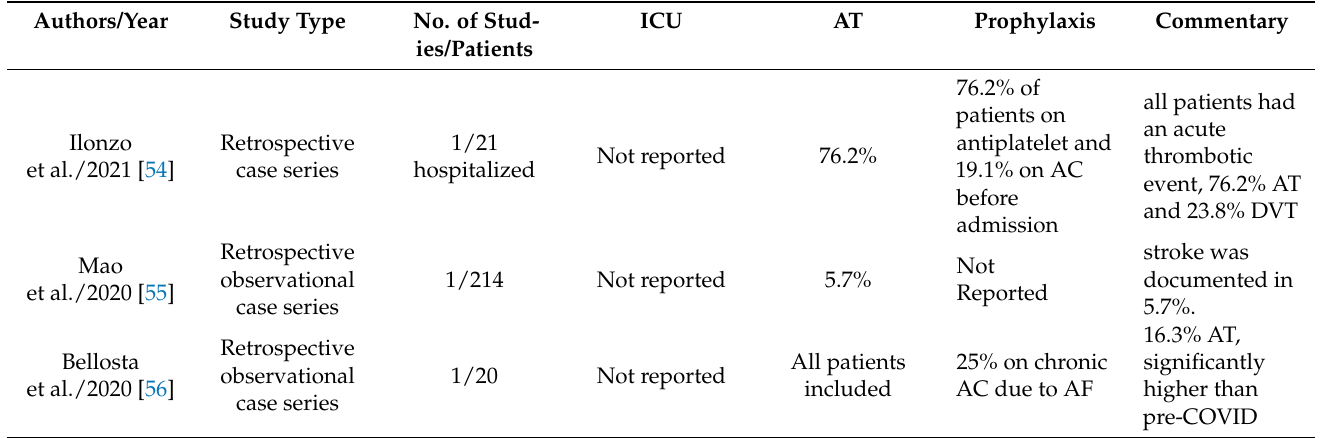
Table 2. Medical literature studies referring to arterial thrombotic events in hospitalized